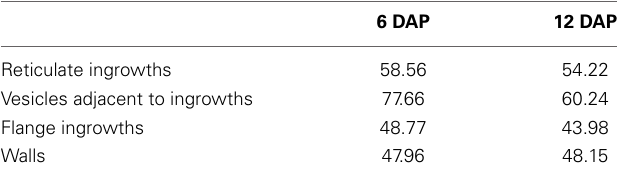
Table 3 | Average lignin content ( ± standard error) in the dry matter of wall material ( µ g mg − 1 ) extracted by the acetyl bromide